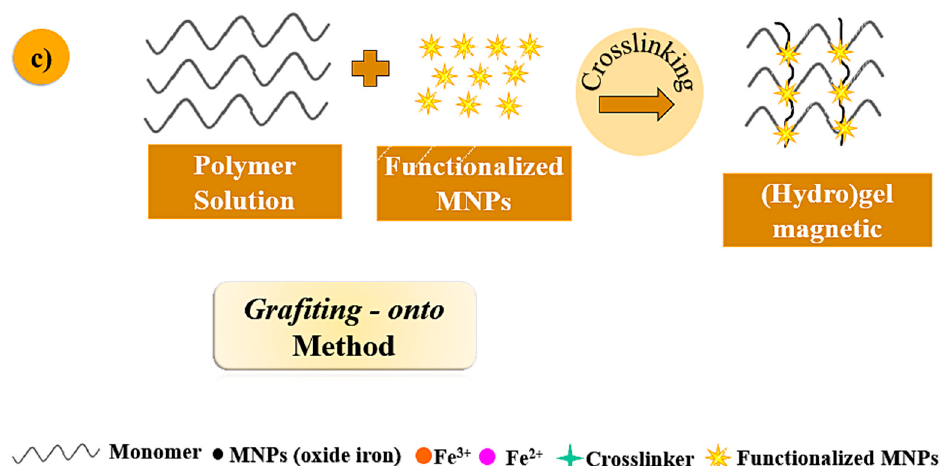
Figure 2. Schematic representation of the methods used to prepare magnetic gels: ( a ) direct blending; ( b ) in situ; ( c ) grafting-onto